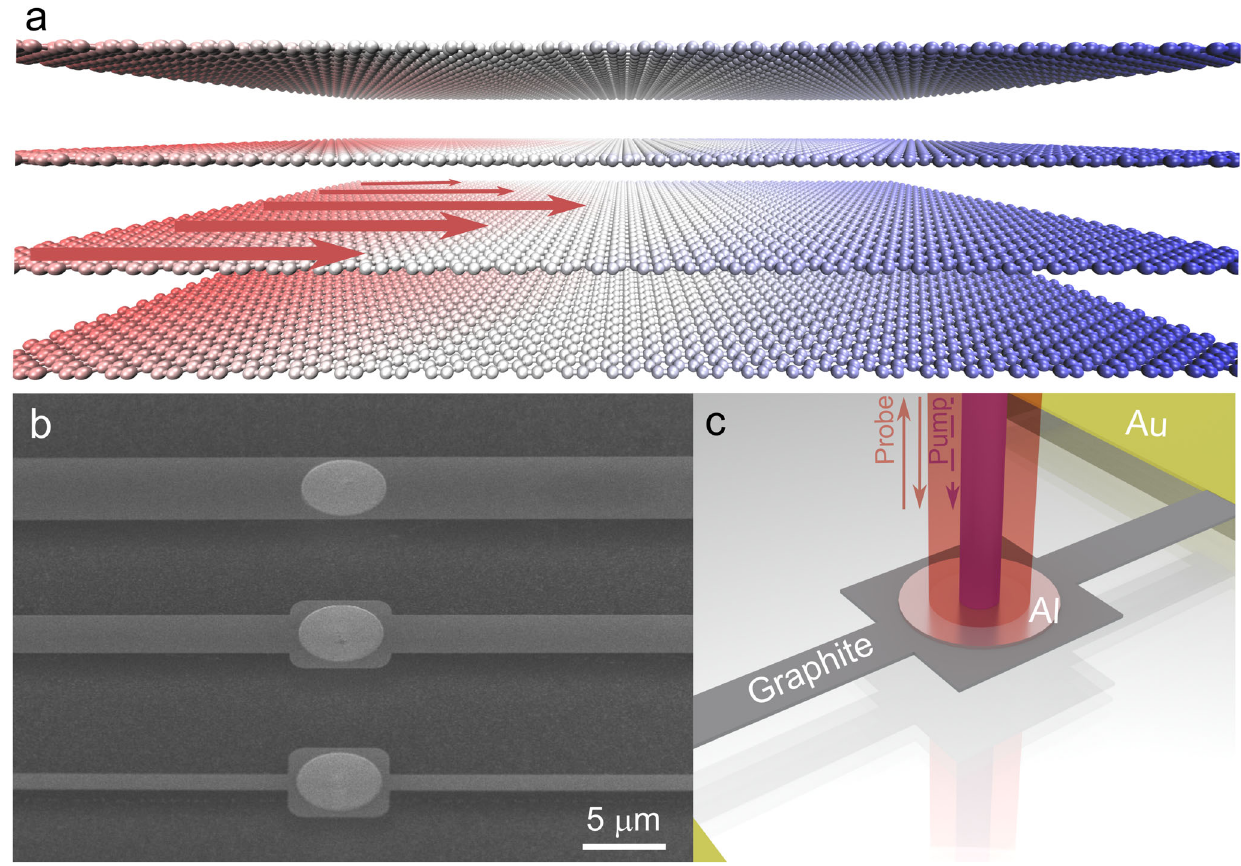
Fig. 1 | Isotopically puri fi ed graphite ribbons and measurement method. a Illustration of phonon Poiseuille fl ow in graphite ribbon. In the hydrodynamic regime, the heat fl ux (represented by the red arrows) manifests a parabolic pro fi le